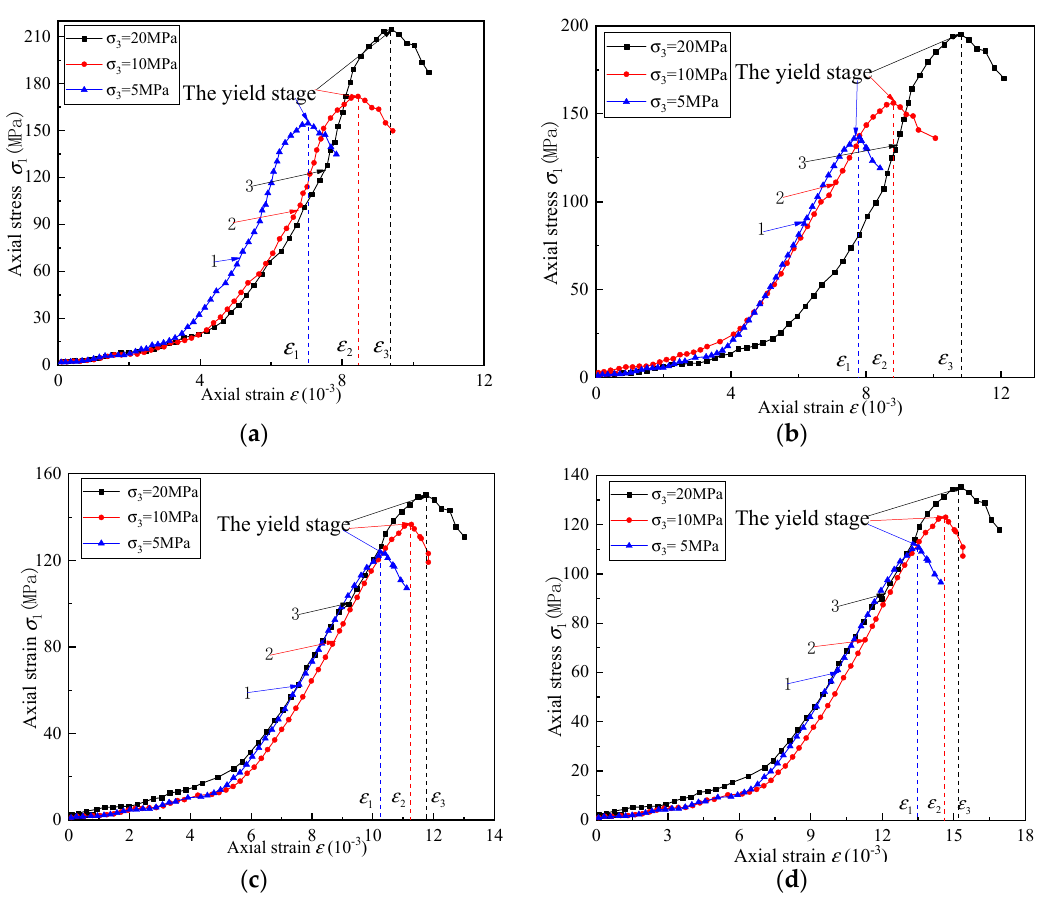
Figure 8. Plot of axial stress versus axial strain for triaxial test from 5, 10 and 20 Mpa levels of confining pressure: ( a ) D = 0.043, ( b ) D = 0.357, ( c ) D = 0.625, ( d ) D = 0.754.